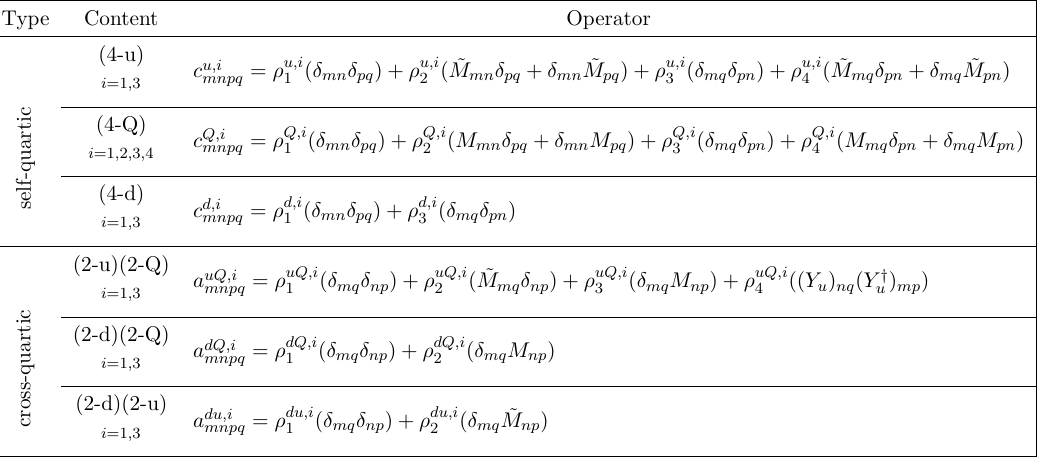
) -MVF expansion of the self-quartic and cross-quartic Table 3 . O ( Y 2 Y 0 u d